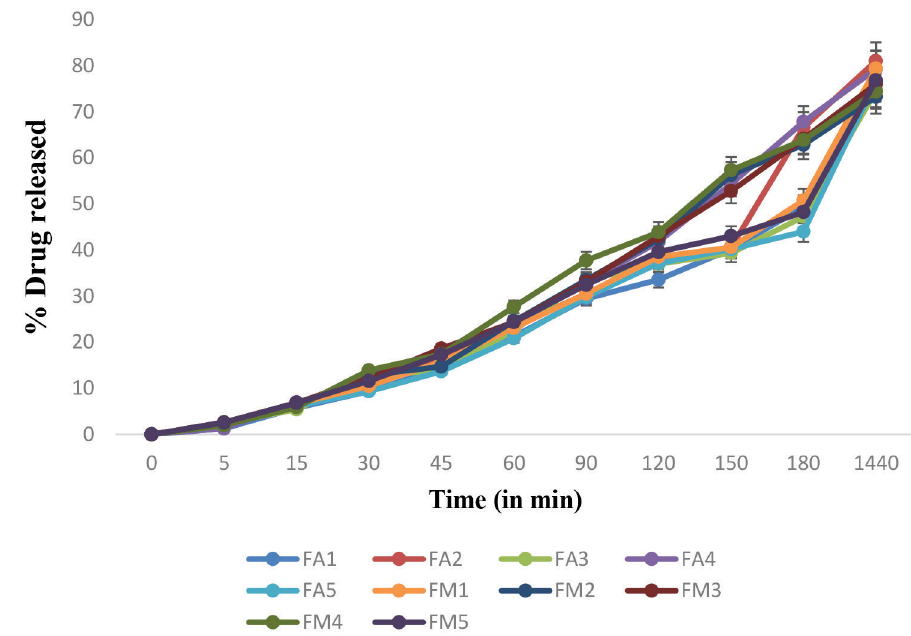
FIGURE 5 - In-vitro drug release study by franz diffusion cell apparatus.